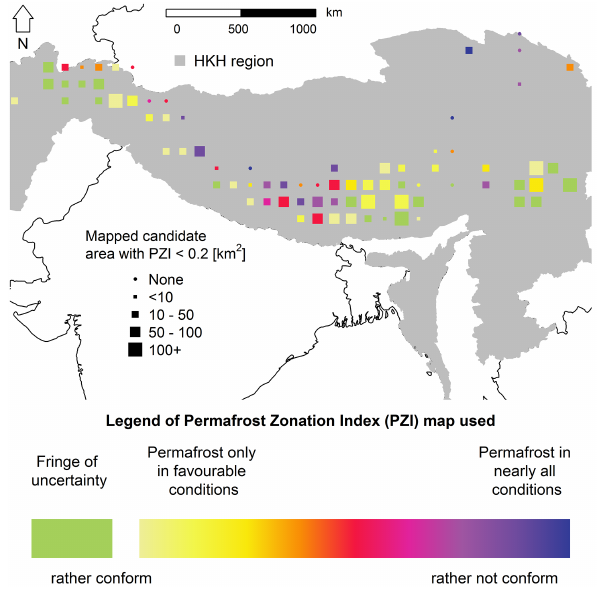
Figure 8. Spatial patterns of agreement between mapped rock glaciers and PZI. Color indicates the lowest PZI value in the mapped rock glaciers within each 1 ◦ × 1 ◦ square. Green and yellow are signalling an apparent good agreement between lowest elevations reached by rock glaciers and predicted lowest possible elevations for permafrost by the PZI. The size of square symbols indicates the size of the mapped candidate area with PZI < 0.2. This is a proxy for whether or not rock glaciers with low PZI values can be expected in this